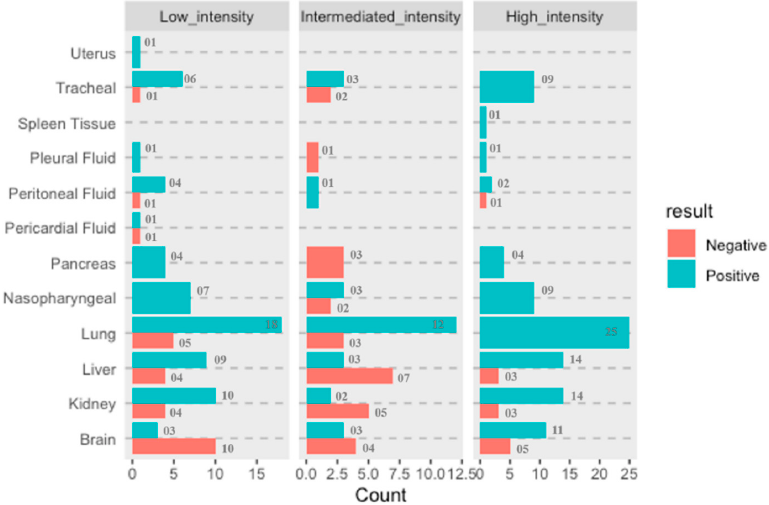
Figure 4. Representation of the proportionate of organ involvement and COVID-19 viral load inten- sity (low, intermediate, and